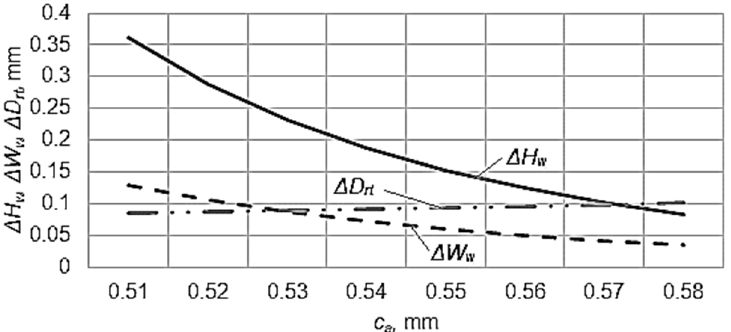
Figure 8. Influence exerted by the axial clearance c a on the deviations Δ H w , Δ W w , and Δ D rt ( t w = 4 mm, l s = 6.5 mm, c s = 0.14 mm).